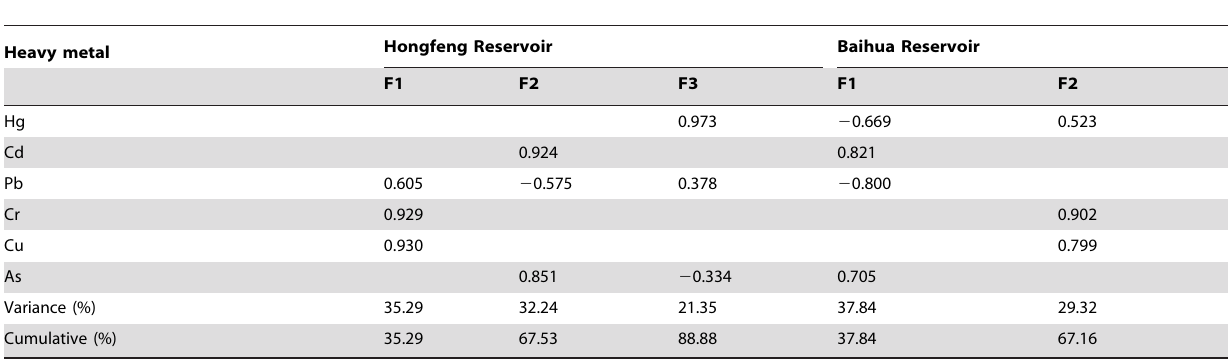
Table 5. Principal Component Analysis (PCA) for heavy metals in surface sediments from the Hongfeng and Baihua Reservoirs.